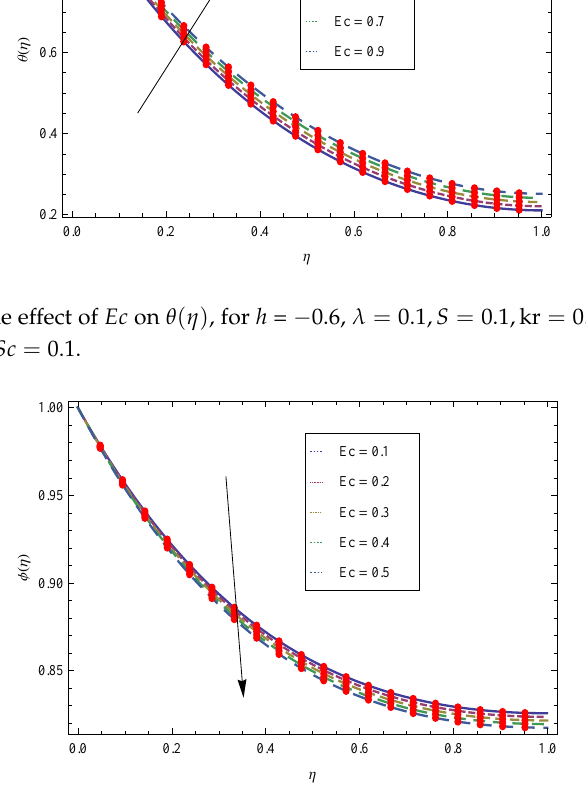
Figure 18. presents the effect of Ec on φ ( η ) for h = − 0.7, λ = 0.5, S = 0.7,kr = 0.2,Pr = 10,Nb = 0.7, Nt = 0.1, β = 1 and Sc =